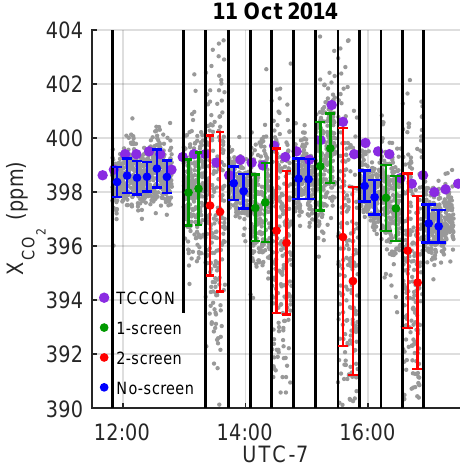
Figure 4. X CO retrievals on 11 October 2014 when mesh screens 2 were repeatedly moved in front of and away from the EM27/SUN (with extended InGaAs detector) entrance window. Gray points are all EM27/SUN measurements. Large points are 10min averages. Error bars are 1 σ . This test was performed a few days after the mirrors were